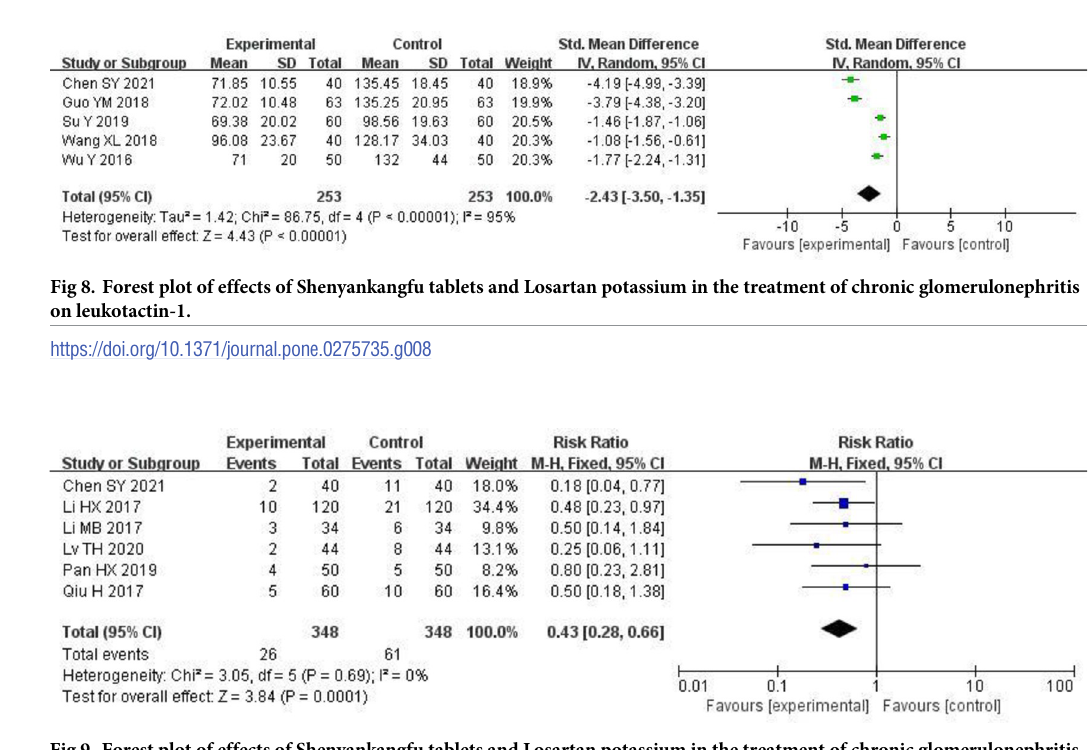
Fig 9. Forest plot of effects of Shenyankangfu tablets and Losartan potassium in the treatment of chronic glomerulonephritis on adverse reaction. https://doi.org/10.1371/journal.pone.0275735.g009 PLOS ONE | https://doi.org/10.1371/journal.pone.0275735 October 10,